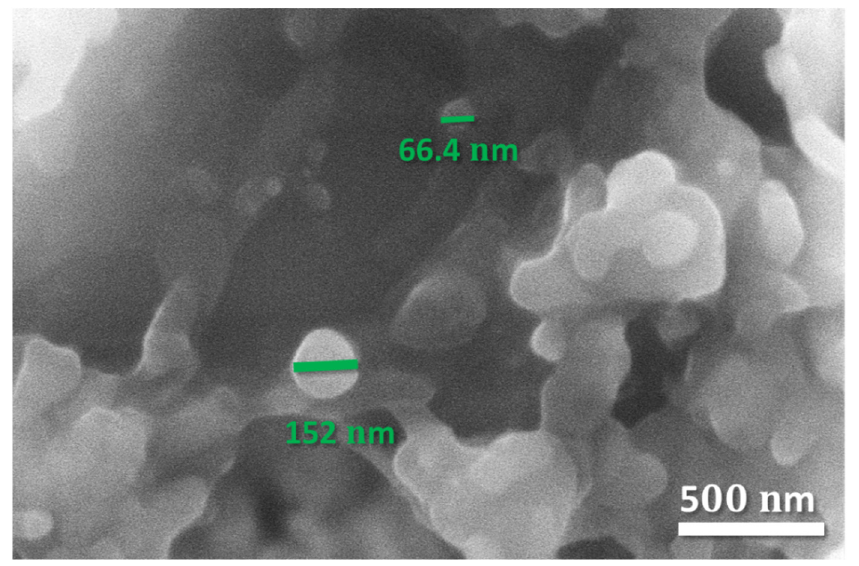
Figure 3. SEM (Scanning Electron Microscopy) image of MCF-7 exosomes on porous gold substate; the average size is 152 nm.